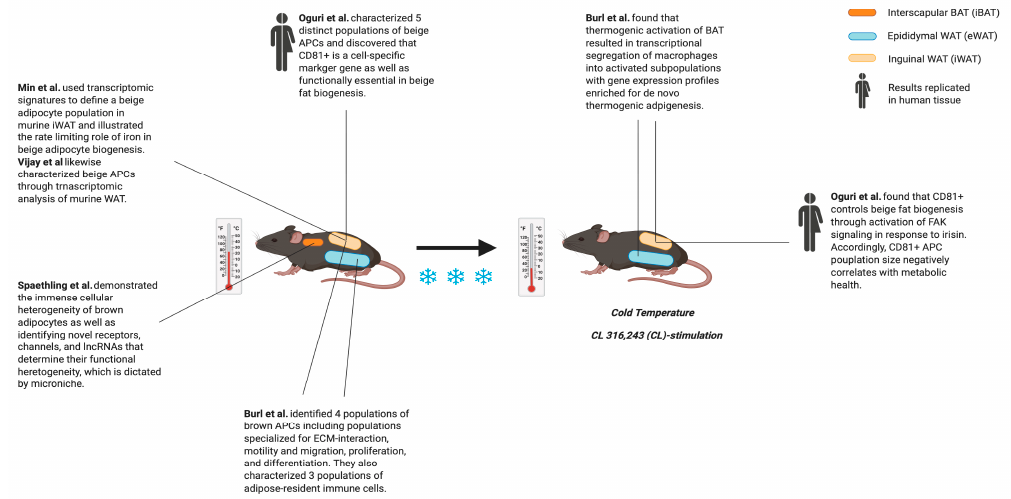
Figure 3. Single-cell genomics identifies a subset of adipocyte precursor cells (APCs) and molecular regulators critical for the beiging of White Adipose Tissue (WAT).